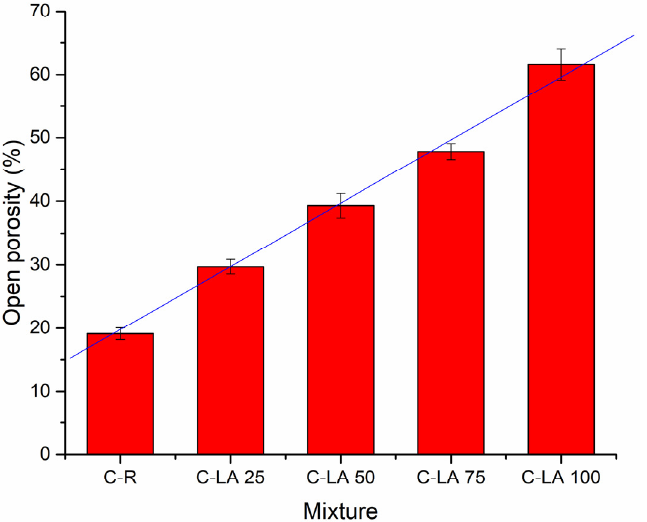
Figure 4. Open porosity development for reference and lightweight aggregate adjusted concretes.